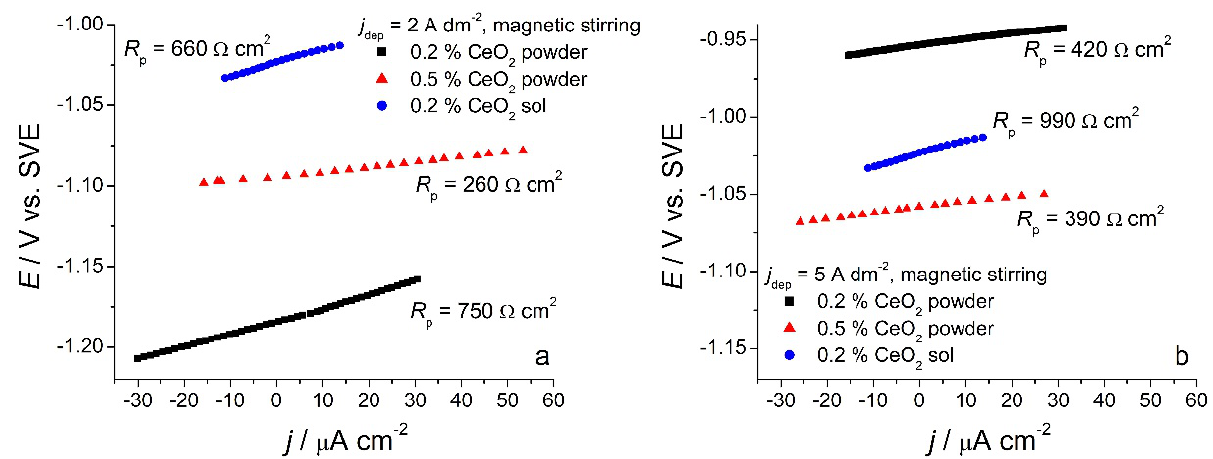
Figure 8. Polarization curves of different composite coatings deposited at ( a ) 2 A dm − 2 and ( b ) 5 A dm − 2 in the small range vs. E ocp in 0.5 mol dm − 3 NaCl.